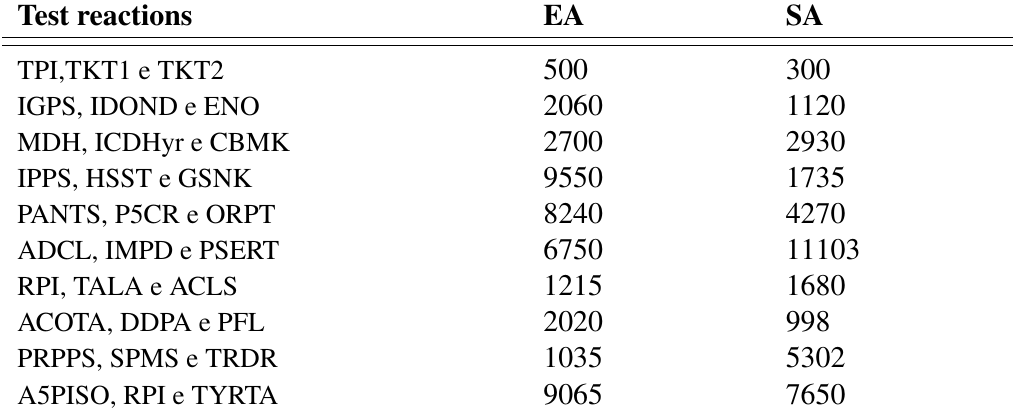
Table 1: Number of function evaluations to find the optimal solution using SA and EA algorithms.